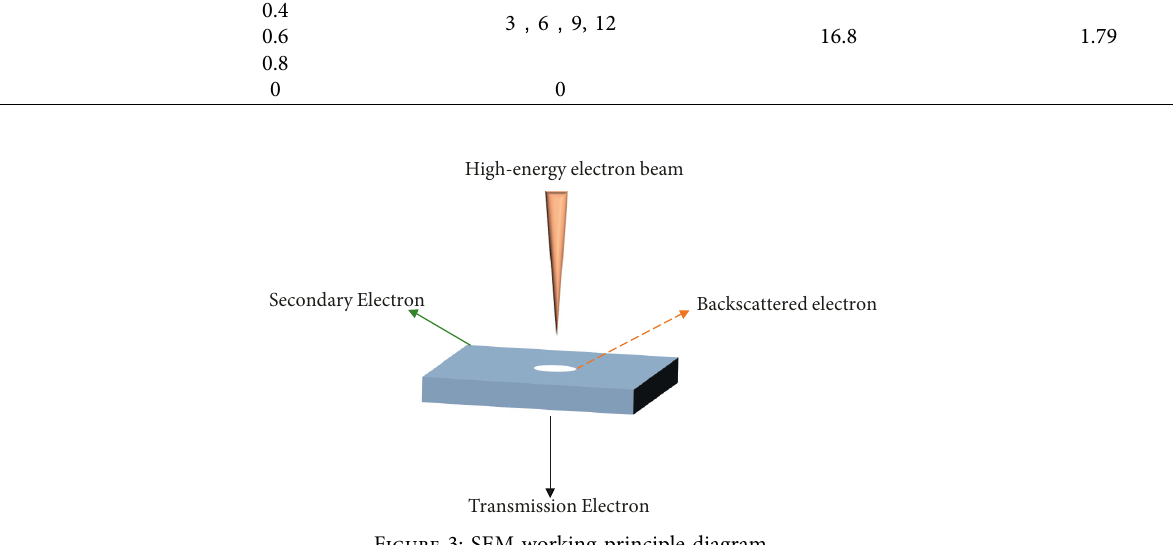
Figure 3: SEM working principle